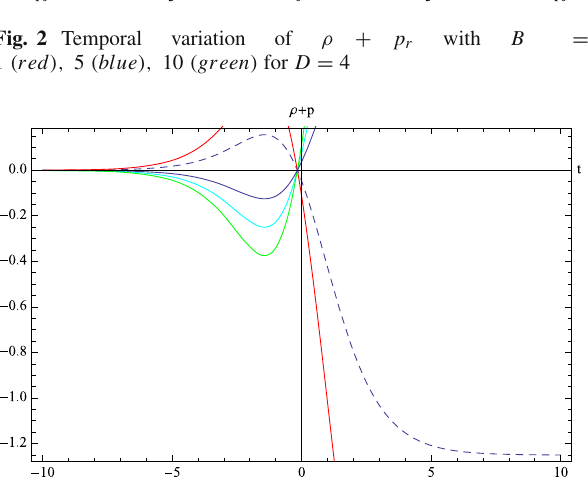
Fig. 3 Temporal variation of ρ + p r with A = − 1 / 3 ( red ), − 0 . 8 ( dashed ), 1 / 3 ( green ), 1 ( blue ) for D =